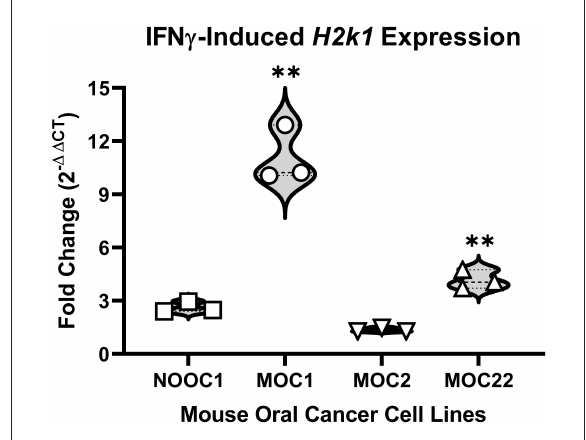
FIGURE1 MHC class I expression of mouse oral cancer (MOC) lines. MHC class I transcription factor H2k1 expression after 24-h stimulation with either vehicle (0.01% BSA) or 100ng/ml interferon gamma (IFN γ ). Cycle threshold values were normalized to housekeeping gene, beta Actin, and reported as fold change (2 − 11 CT ) from vehicle treatment. Independent t-test , ** p <